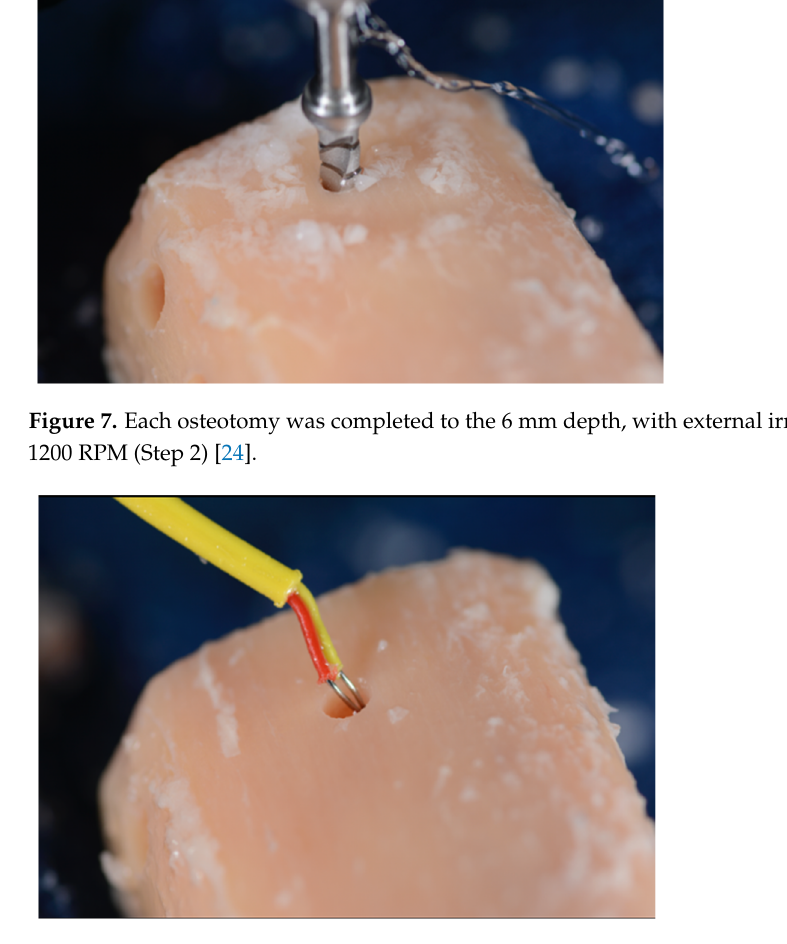
Figure 8. The thermocouple probe was inserted along the osteotomy wall and floor and the highest temperature value was recorded immediately after osteotomy preparation to the 6 mm depth (Step 3) [24].